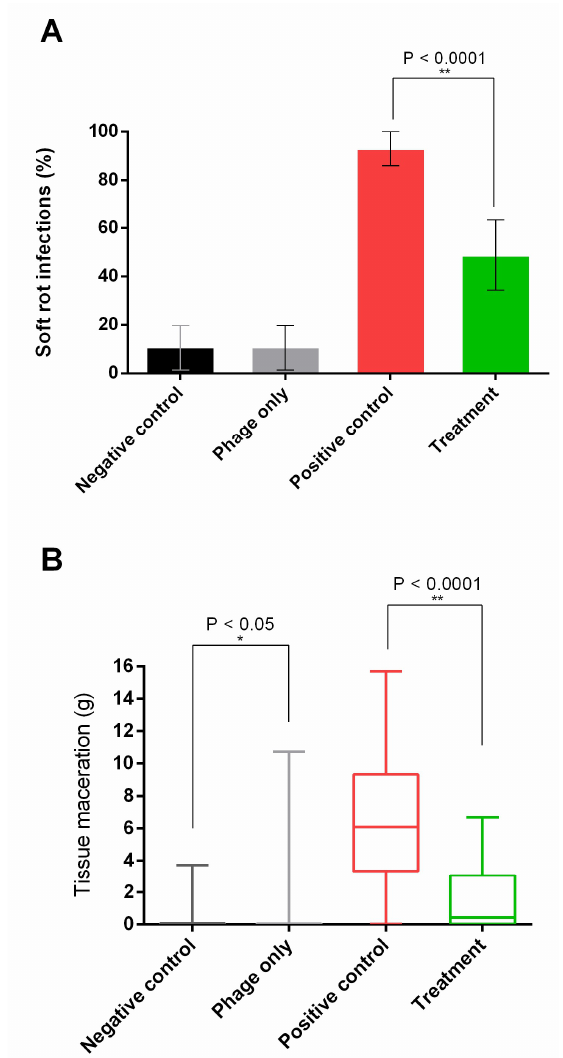
Figure 4. Potato maceration assay: Negative control (black); potatoes not exposed to neither phages nor bacteria. Phage only (grey); Potatoes washed in phage cocktail solution, but not exposed to bacteria. Positive control (red); Potatoes washed in sterile water and inoculated with bacteria. Treatment (green); Potatoes washed in phage solution and inoculated with bacteria. N = 45 for each treatment group. ( A ) Soft rot disease incidence (%): Positive soft rot infection was identified as the presence of >0.5 g macerated potato tissue. Numbers indicate the percentage of infected potatoes; error bars show 95% confidence interval. The treatment group showed a significant reduction compared to the untreated group (Chi-squared test, P < 0.0001). ( B) Box plot showing the amount of macerated tissue (g) of potatoes after 5 days incubation.